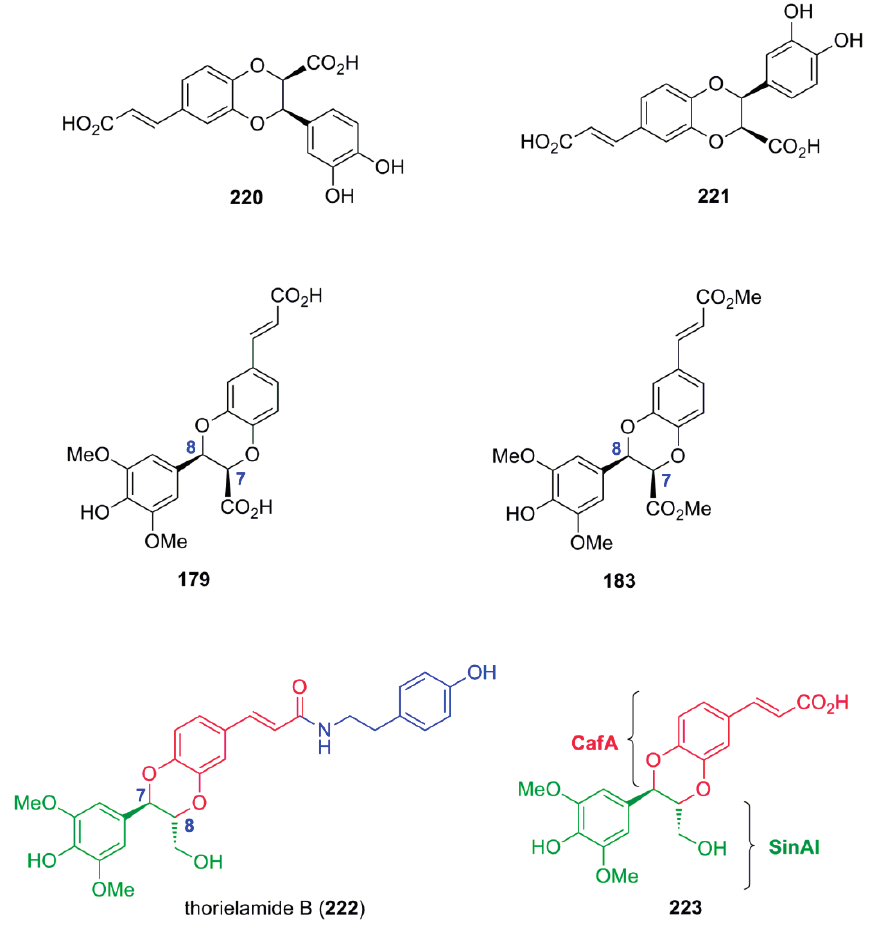
Figure 18. Structures of oxyneolignans of the 1,4-benzodioxane